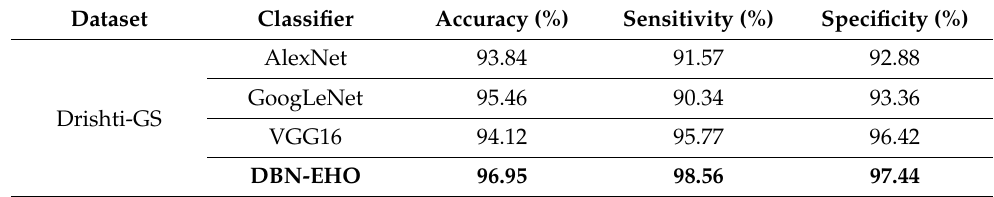
Table 10. Comparison of DBN-EHO with CNN models employing transfer learning.